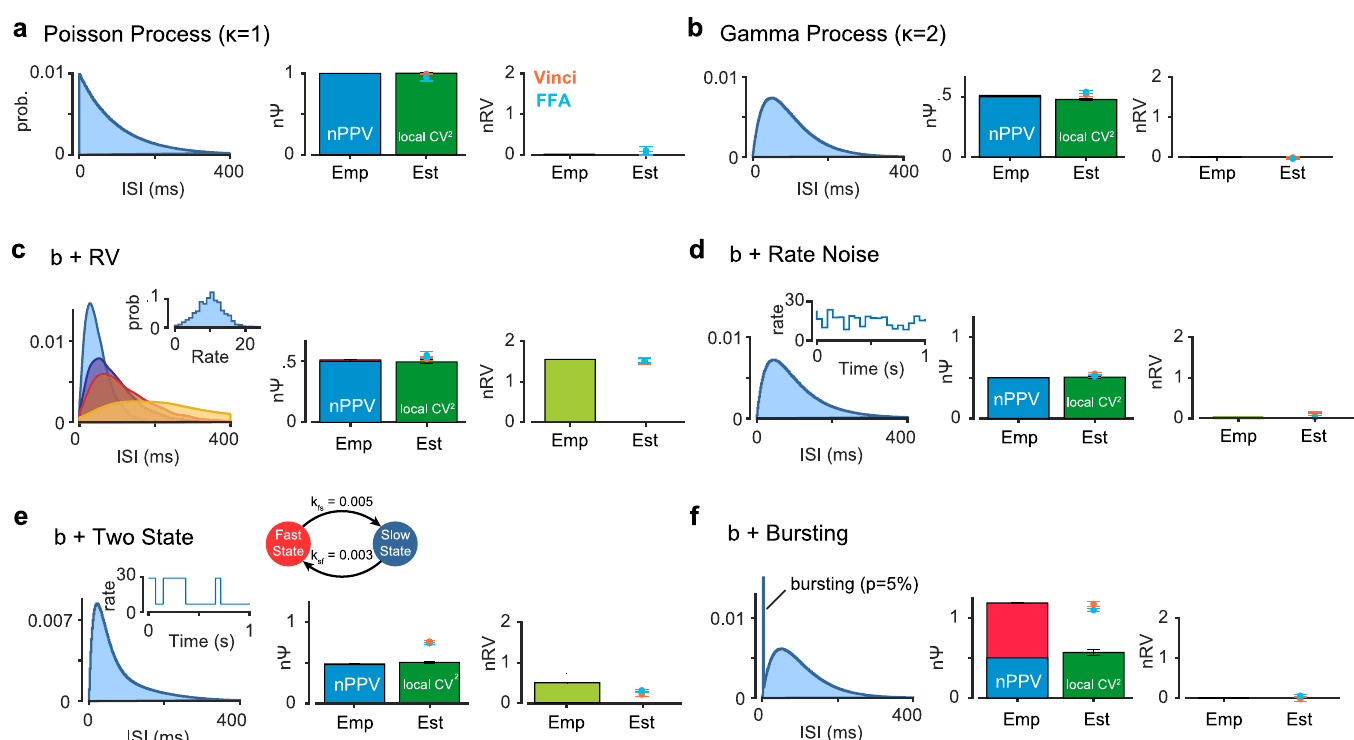
Fig 2. Normalized point process variability (nPPV) and bursting contribute to spiking irregularity (n C ). Empirical estimations (by generating several samples from each trial, see S1 Text) of n C and nRV along with estimations made by FFA and Vinci methods. Theoretical nPPV and its estimate using CV 2 box represents total empirical n C ; blue box represents theoretical nPPV (1/ κ ); dark green box represents estimated CV 2 of nRV; orange and blue dots represent Vinci and FFA estimates for n C and nRV in the corresponding plots; errorbars are sem. (a) Poisson process with rate 10Hz with no rate variability. (b) Gamma process ( κ = 2) with no rate variability. (c) same as b but doubly stochastic with rate variability. (d) same as b but with within trial white noise added to the constant rate (~ N (0,3) and Δ t 50 ms , see S1 Text). (e) same as b but with within trial state switching between high and low-rates imposed (see S1 Text). (f) An example ISI distribution with bursting imposed with probability 0.05 on a given spike; during generation of the process, each spike was replaced by 5 consecutive spikes with 3ms